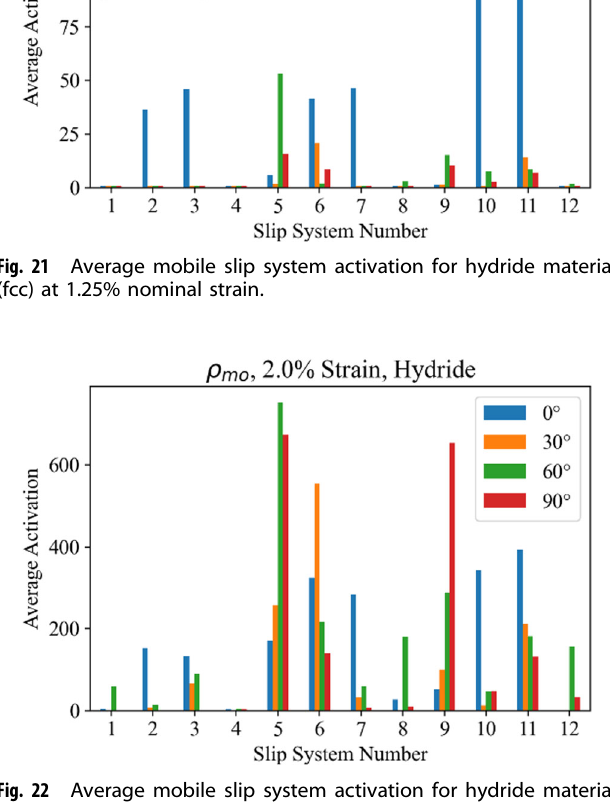
Fig. 19 Average immobile slip system activation for parent material (hcp) at 1.25% nominal strain.